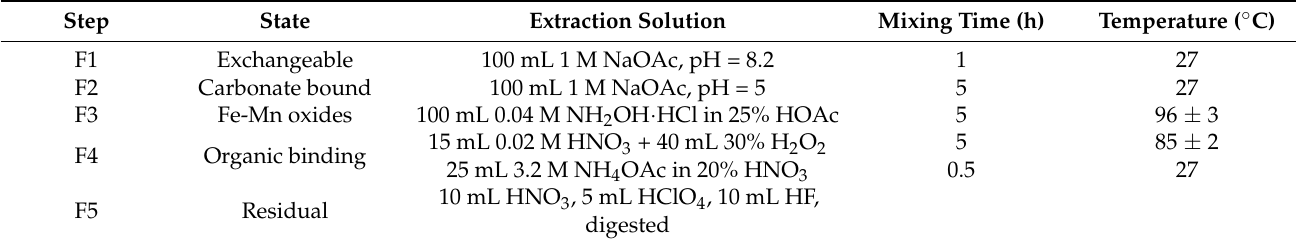
Table 3. Sequential extraction procedures.